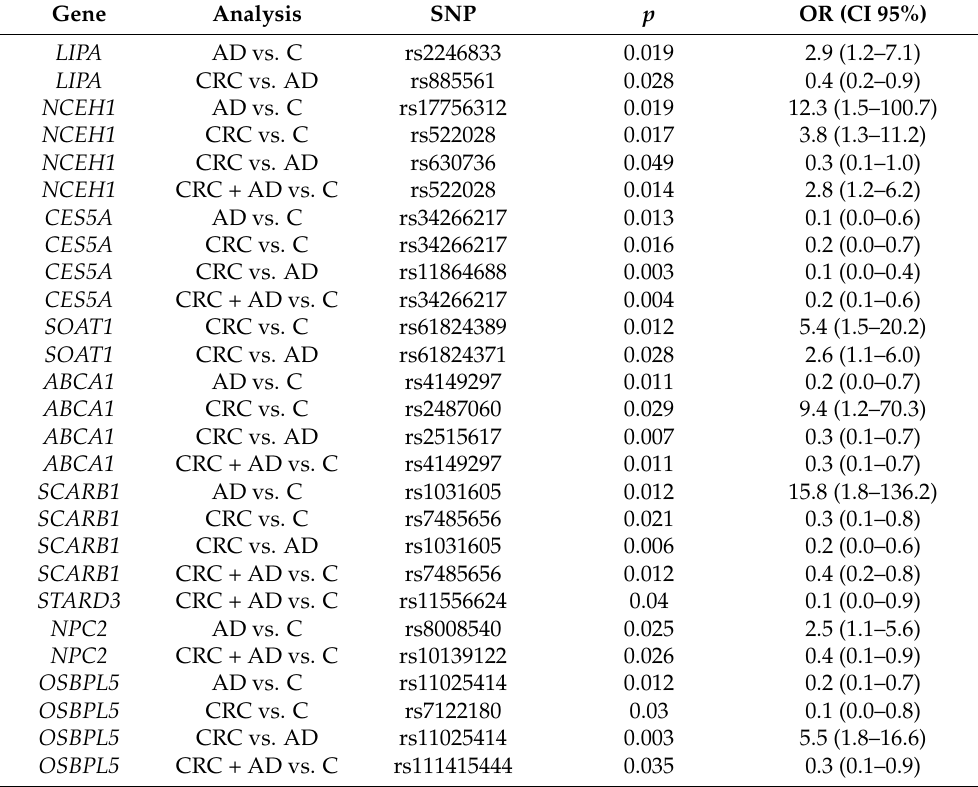
Table 1. Association study results of significant SNPs in genes of “Cholesterol esters metabolism pathway”. AD vs. C, adenoma vs. healthy controls; CRC vs. C, colorectal cancer vs. healthy controls; CRC vs. AD, colorectal cancer vs. adenoma; CRC + AD vs. C, adenomas and colorectal cancer vs. controls. OR, odds-ratio; CI 95%, 95% of confidence interval of odds-ratio.